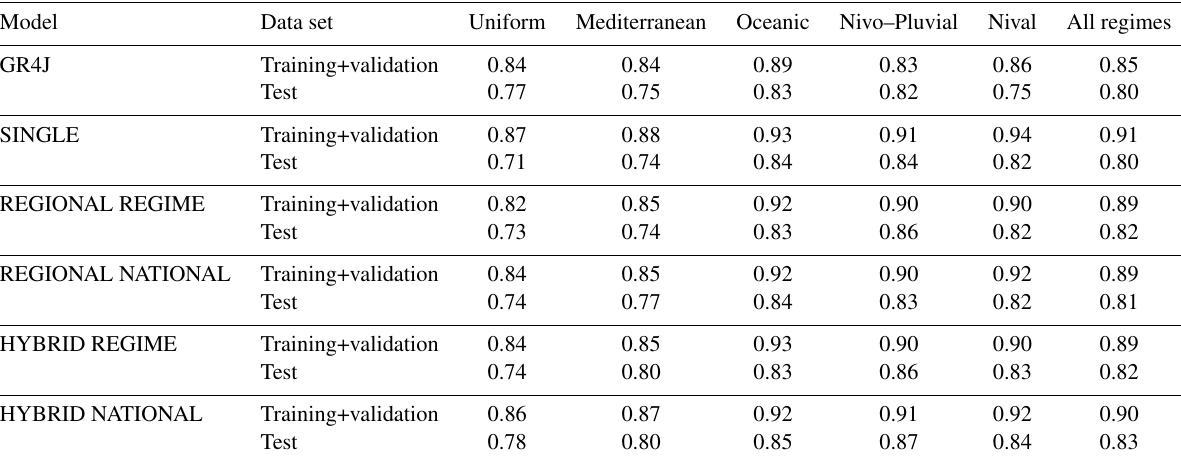
Figure 11. Cumulative distribution functions (CDFs) of the KGE scores of the test data for the group-trained LSTM models: REGIONAL REGIME (orange), REGIONAL NATIONAL (green), HYBRID REGIME (red), and HYBRID NATIONAL (purple). From top to bottom, the first five panels indicate the CDFs for each of the five regimes: Uniform, Mediterranean, Oceanic, Nivo–Pluvial, and Nival. The last panel corresponds to the distributions of the entire sample. Table 5. Median KGE scores, within different regimes and overall, for the GR4J model compared to the LSTM models.